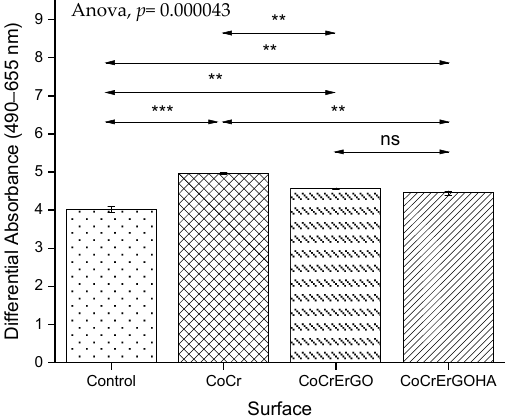
Figure 6. Effect of CoCr, CoCrErGO, and CoCrErGOHA on the total LDH content of osteoblast ‐ like MC3T3 ‐ E1 cell cultures. Osteoblasts were also cultured in the absence of any discs, and used as control. ns: p > 0.05, **: p ≤ 0.01, ***: p ≤ 0.001.